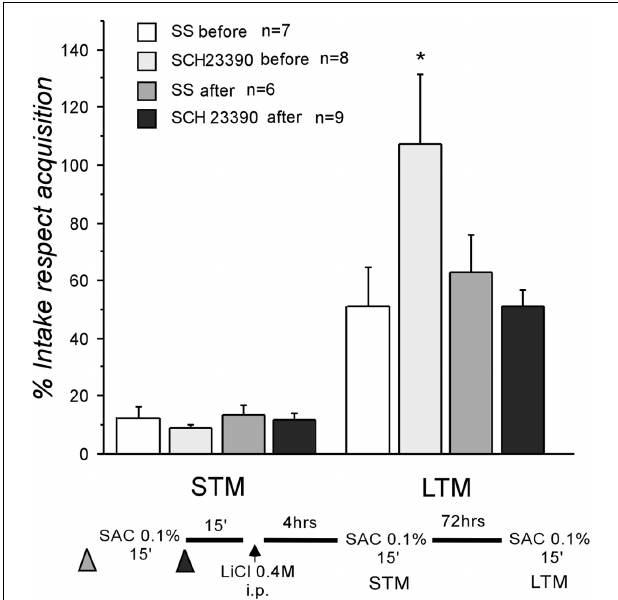
FIGURE 2 | Short- and long-term memory (STM and LTM) effects of the intra-cortical infusion of SCH23390, a D1 receptors antagonist, into the IC. “SCH23390 before” group and a control group that received saline solution injections (SS before) were injected 15min prior CTA training (gray triangle) that consisted in the presentation of a saccharine solution (0.1%) during 15min, followed by an i.p. LiCl administration (0.4M, 7.5mL/kg). “SCH 23390 after” and SS after groups received the injections immediately after the saccharin exposure (black triangle). All the groups showed aversion in the STM test (4h after conditioning), whereas in the LTM test (72h) only the group that was injected with the D1 antagonist shows an impairment of consolidation. Saccharin consumption during the memory tests are expressed as percentage of consumption during acquisition stage ± SEM. * p <